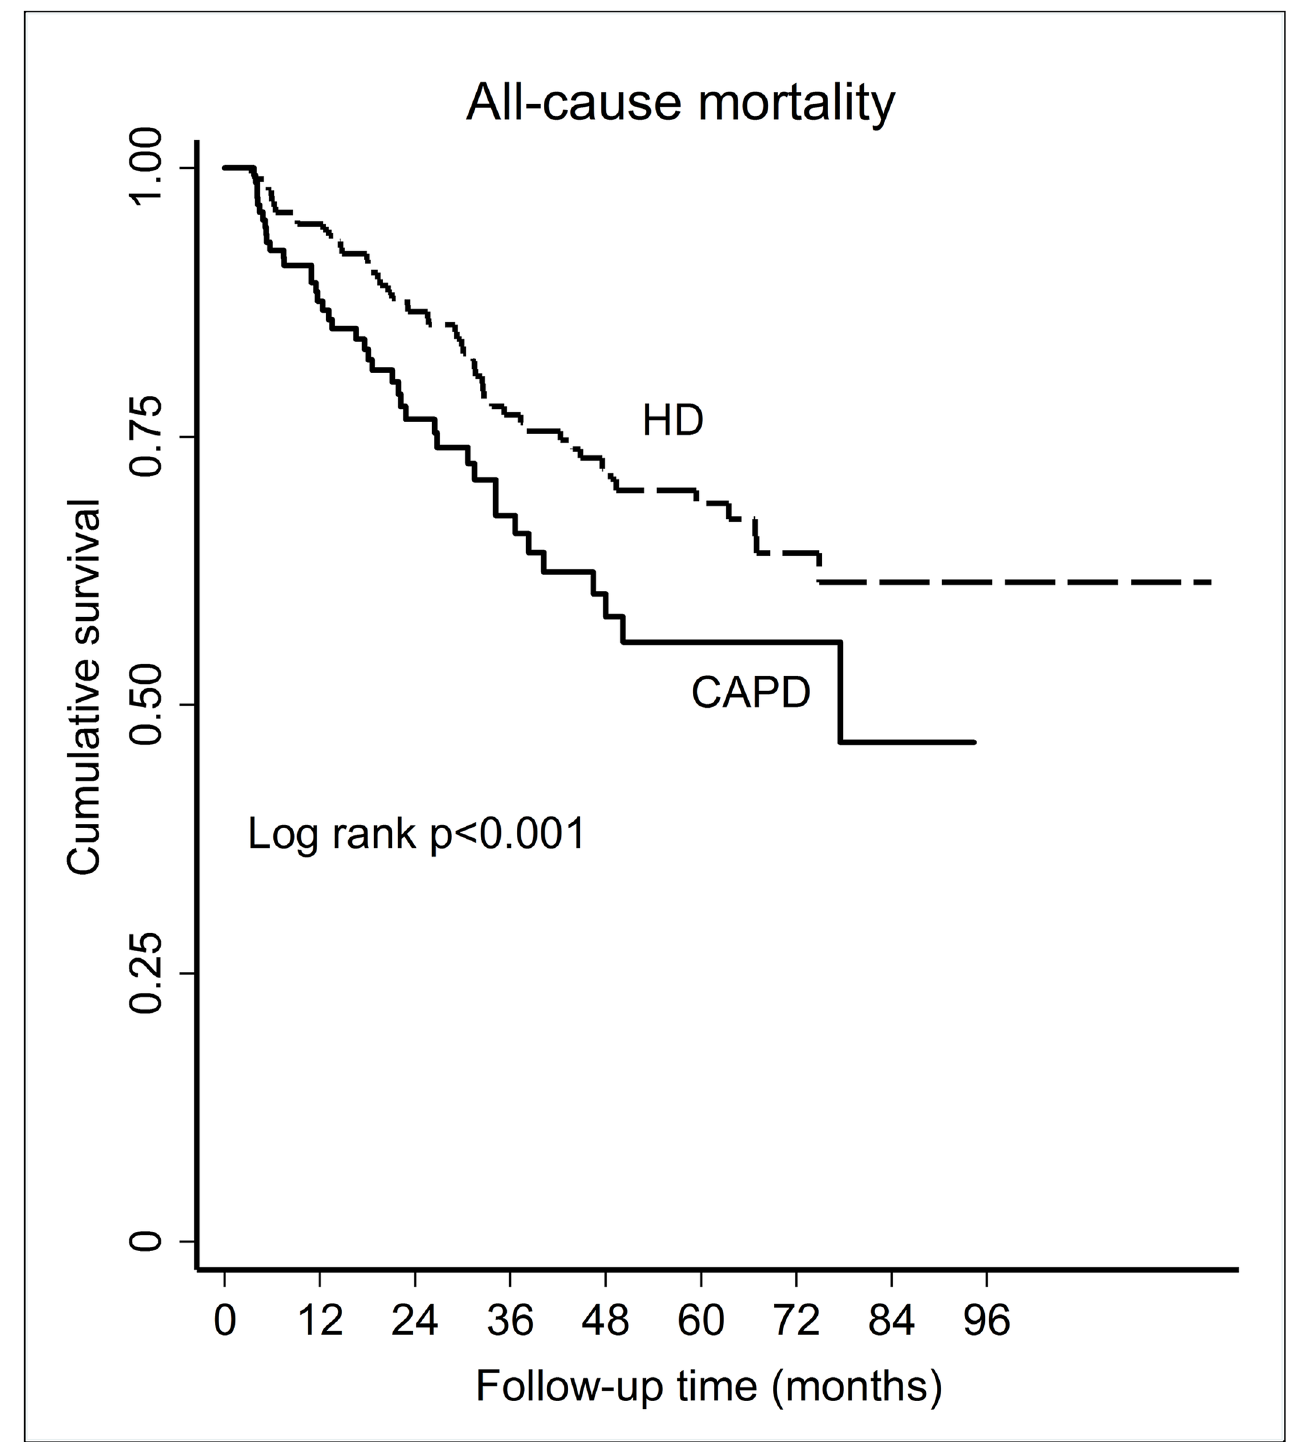
Fig 1. Kaplan-Meier survival curve for all-cause mortality according to dialysis modality.